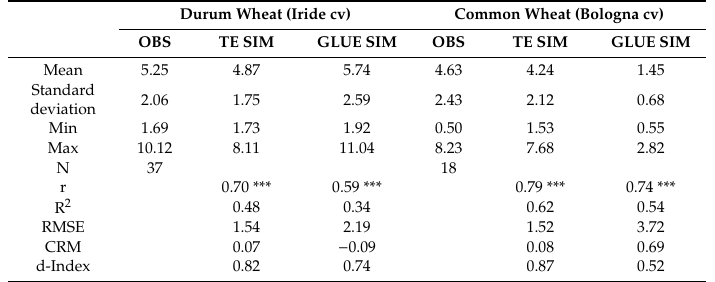
Table 9. Statistical results of observed (OBS) and simulated (SIM) values of grain yield (t ha − 1 ) for durum wheat (Iride cv) and common wheat (Bologna cv) for the calibration of CSM-CERES-Wheat model.